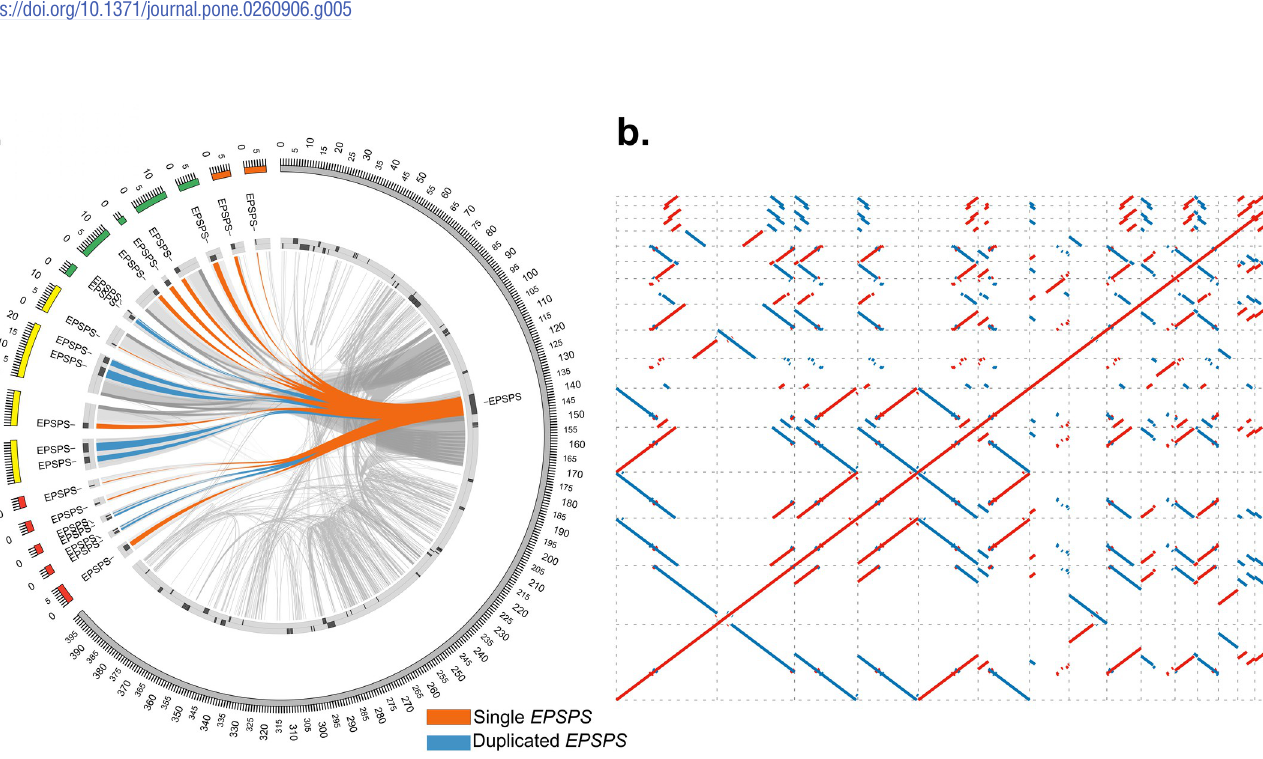
Fig 6. EPSPS gene copies in GR eccDNA. A. Sequence similarity of GR eccDNA aligned to the eccDNA replicon. Blue and orange links indicate single or duplicated EPSPS genes. Grey links show broader sequence similarities. B. Self-alignment of the GR eccDNA containing multiple EPSPS copies. Blue dots indicate inverted repeat sequences and red dots indicate repetitive sequence in the forward